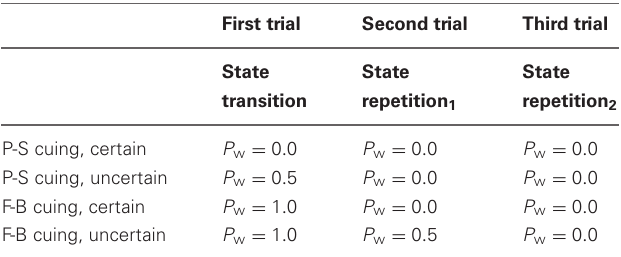
Table 3 | Conditional probabilities for negative trial outcomes in an ideal performer, separately for P-S cuing and F-B cuing as well as for certain and uncertain cuing conditions, further conditioned on the serial position of trials within task